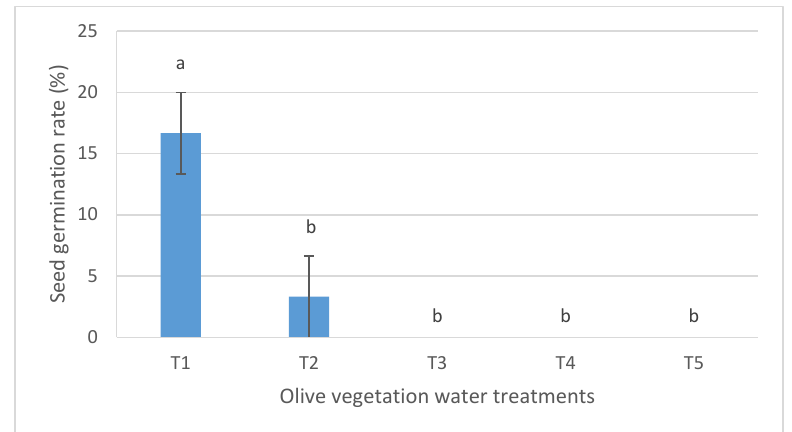
Figure 2. Cheeseweed germination in petri dishes that received 25 mL of OVW at five di ff erent strengths using dilutions with tap water (T1: 0% OVW, T2: 25% OVW, T3: 50% OVW, T4: 75% OVW, T5: 100% OVW). Error bars represent ± standard error. Bars sharing the same letter are not statistically di ff erent according to Tukey’s HSD test (at P <